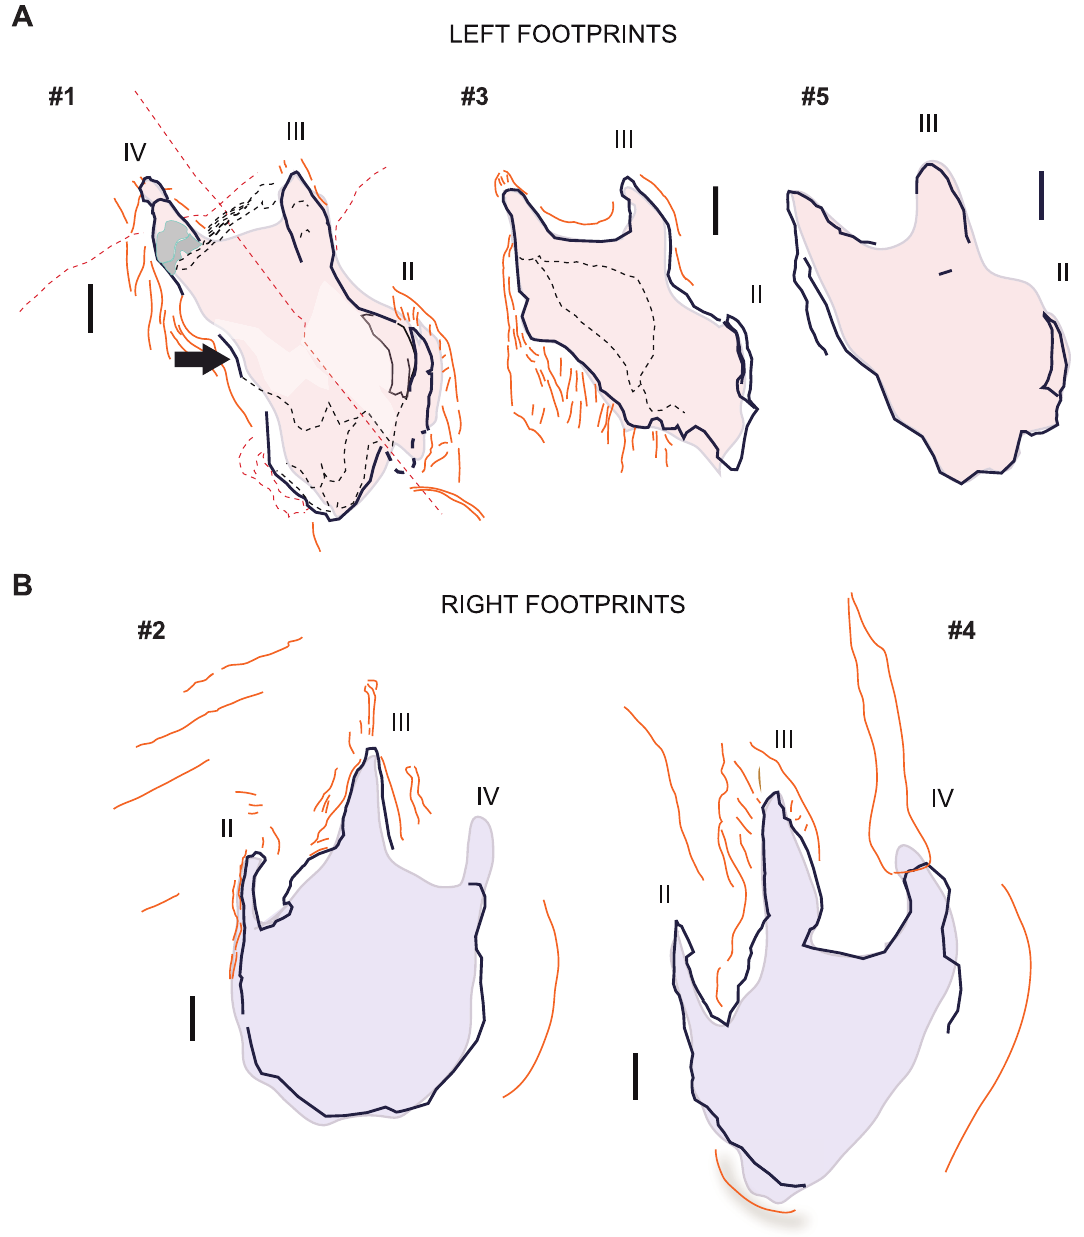
Fig 8. Magenta LH-Mg-10-16 taphonomic features. (A) Left footprints. (B) Right footprints. Black lines corresponds to unambiguous limits, whereas the filling color (red or violet) reflect the overall impression. Lines in orange describe marks around the track (i.e., bulged areas, nail scratches, stepped borders of the contour). Dotted lines correspond to breakages, or discontinuities. The arrow points to the medial indentation. Drawn from photographs of isolated footprints. Scale, 5 cm.